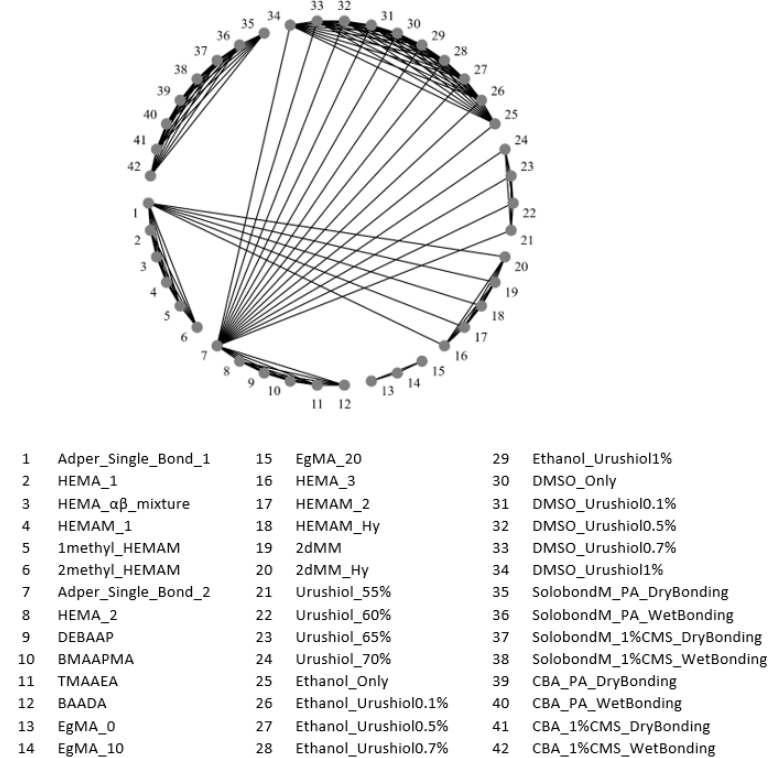
Figure 7. Graph of treatment network in pairs of immediate bond strength.